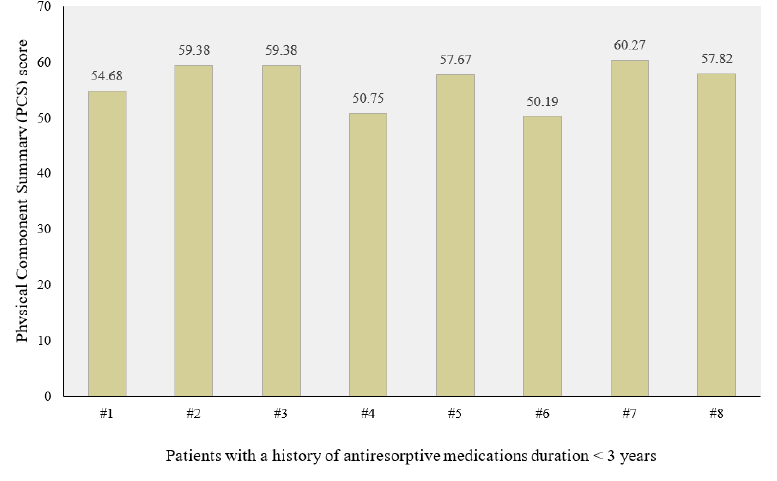
Figure 3. Physical Component Summary (PCS) in patients with a history of anti-resorptive medication duration <3 years.